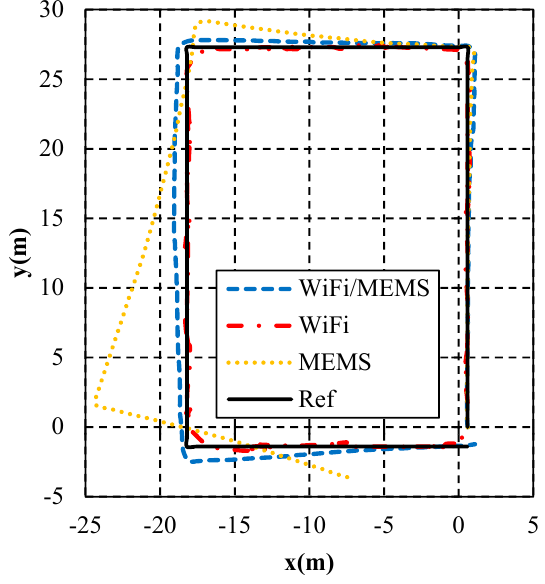
Figure 10. Positioning results. Table 4. Positioning errors and running time.